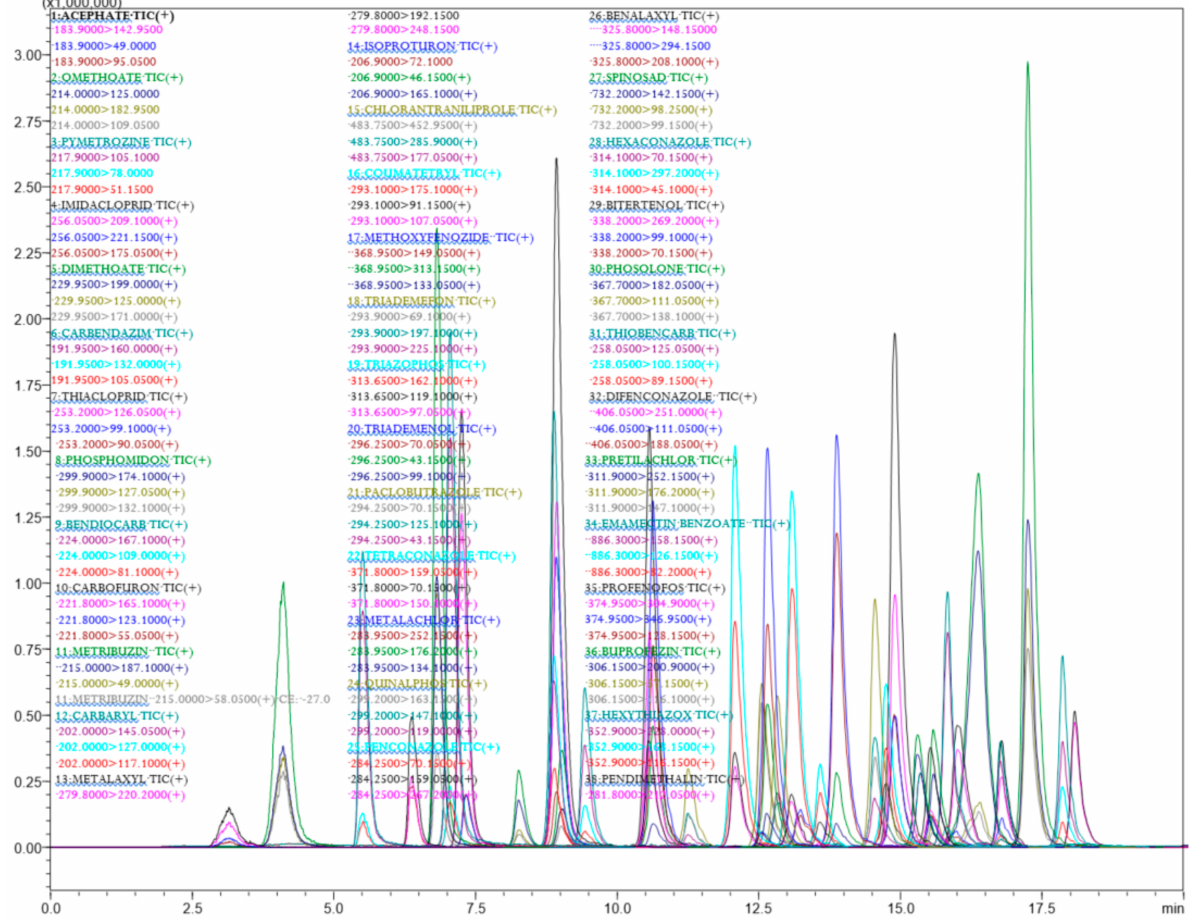
Figure 2. LC-MS/MS chromatograms of 39 pesticides in 25 min run showing different MRM